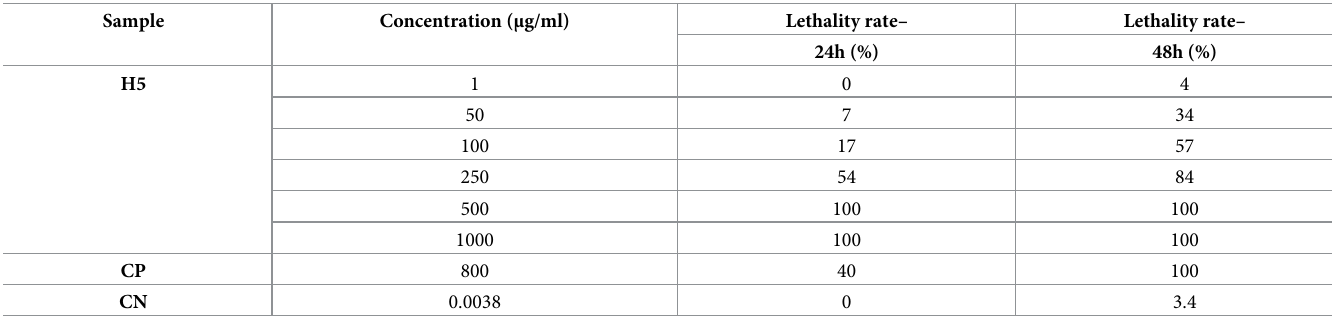
Table 1. Lethality rate of Artemia salina nauplius to hydrazone (H5).